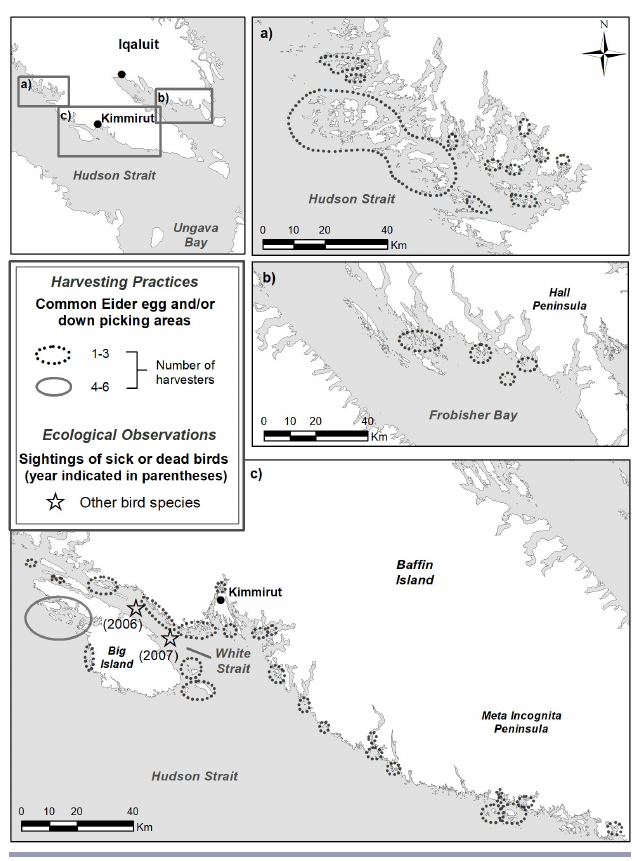
Fig. 3 . Participants’ use of the Common Eider ( Somateria mollissima ) and observations of sick or dead Common Eiders and other birds in Kimmirut,